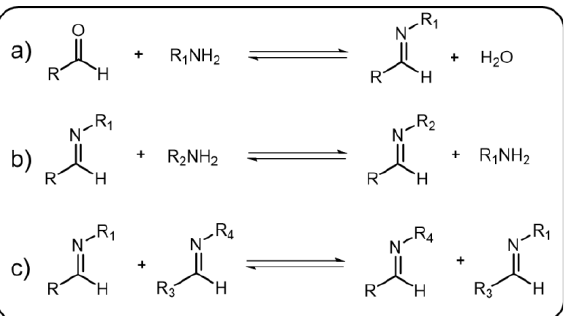
Scheme 2. The three types of imine reactions: ( a ) imine condensation, ( b ) exchange, and ( c )